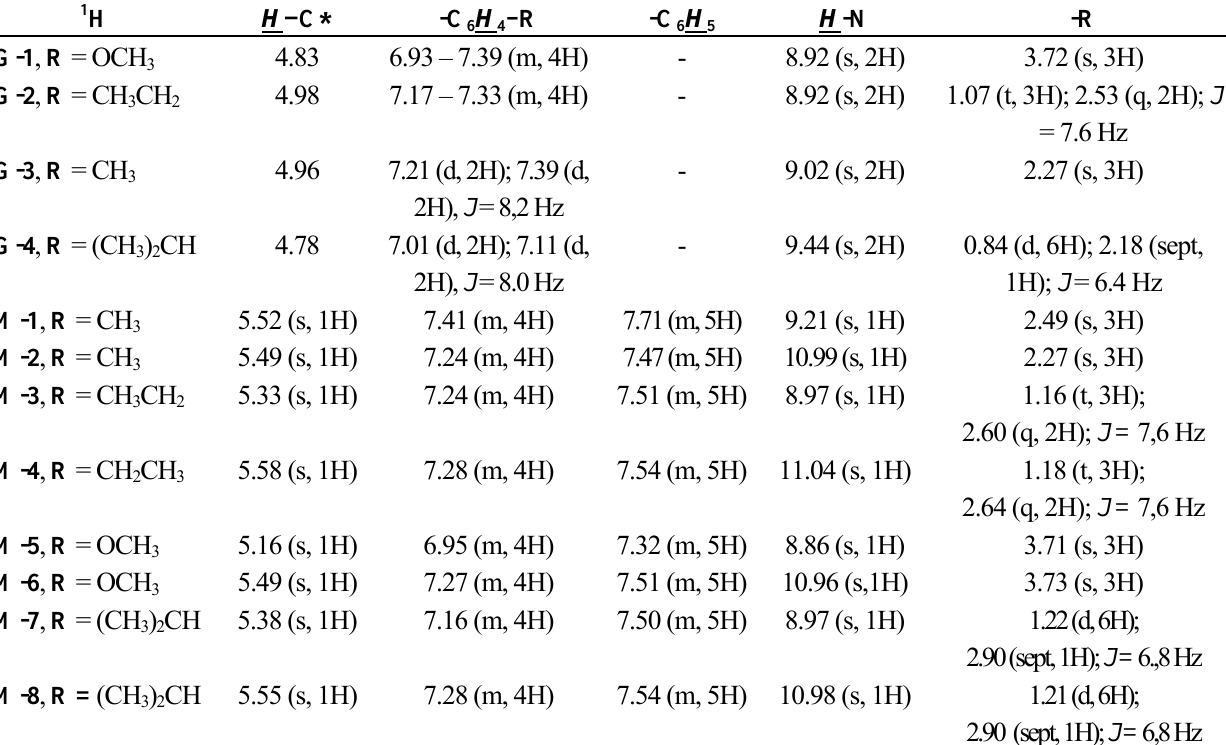
): Chemical shifts δ (ppm) from TMS, J 6